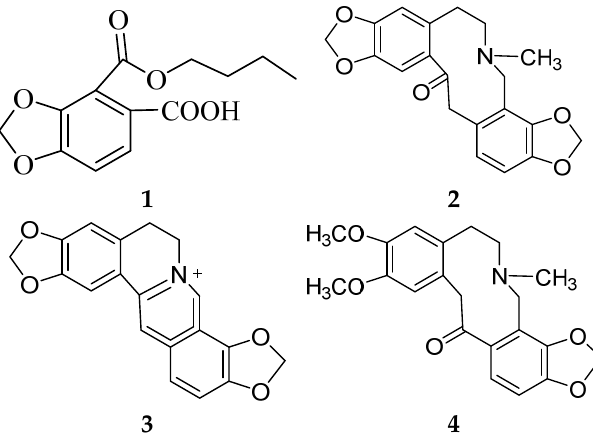
Figure 1. Structures of the compounds ( 1 – 4 ).